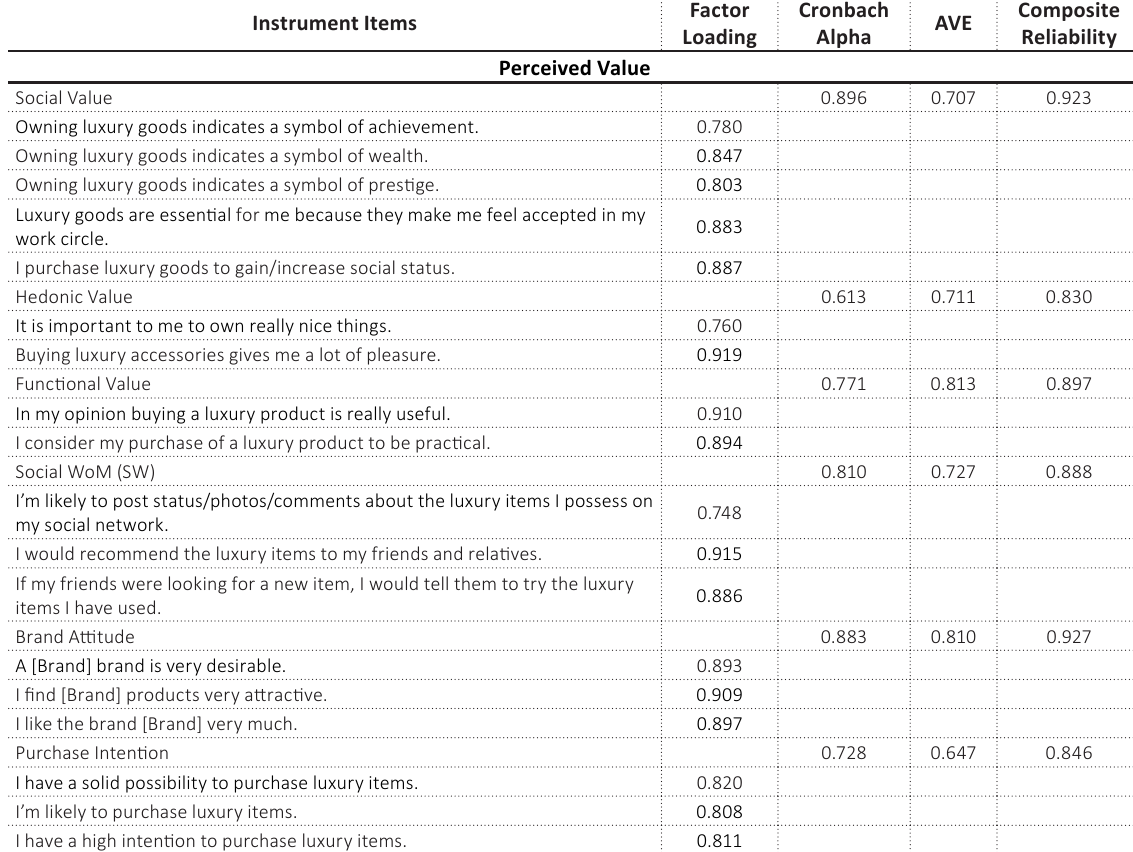
Table 3. Reliability and validity measurement